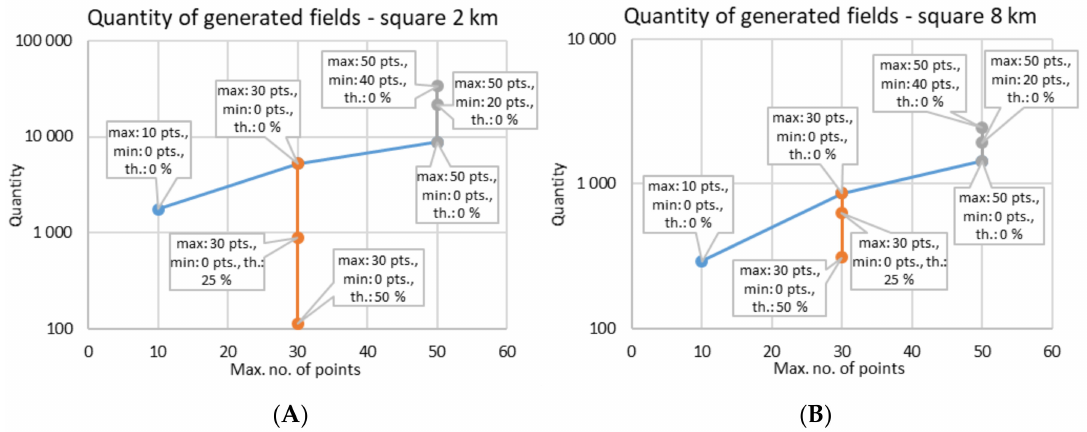
Figure 11. Diagrams of changes in the number of generated primary fields for squares: ( A )—2 × 2 km, ( B )—8 × 8 km.